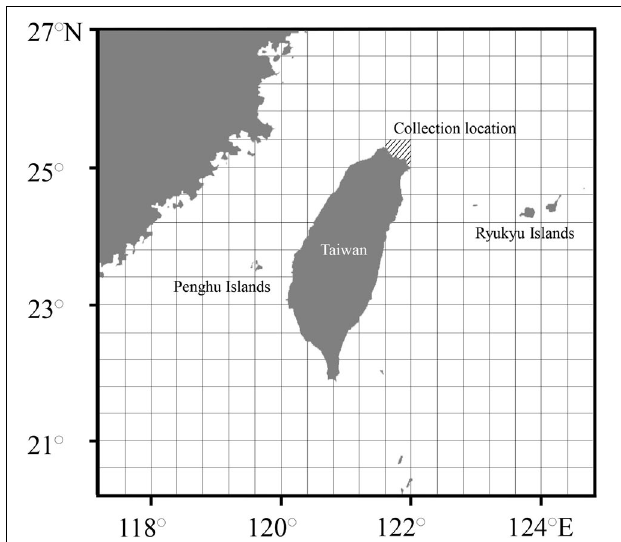
FIGURE 1 | Map showing the collection locations (slanted lines). The unit of spatial grids was 0.4 ◦ × 0.4 ◦ for the establishment of occurrence probability.